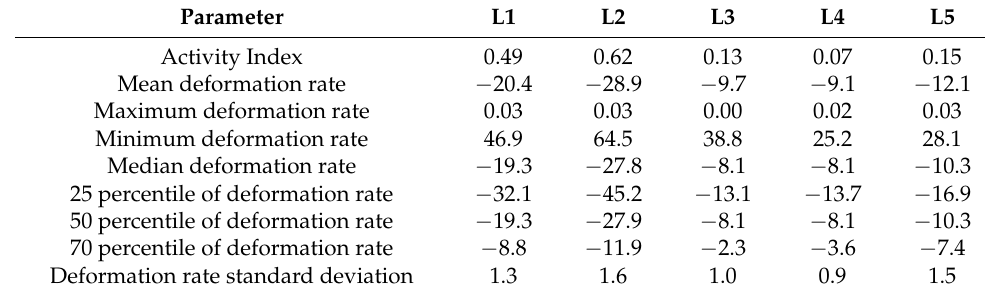
Table 1. Activity parameters of various loess landslides shown in Figure 8. (Unit: mm/year).